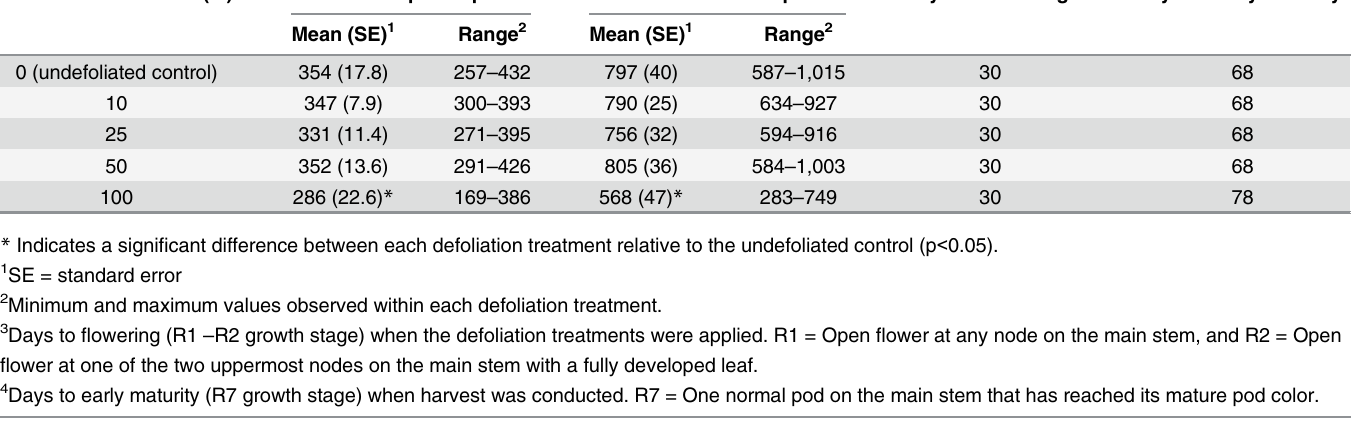
Table 4. The number of pods and seeds per plant, days to flowering and days to early maturity of wild soybean after defoliation treatments. Defoliation treatment (%) Number of pods / plant Number of seeds / plant Days to fl owering 3 Days to early maturity 4